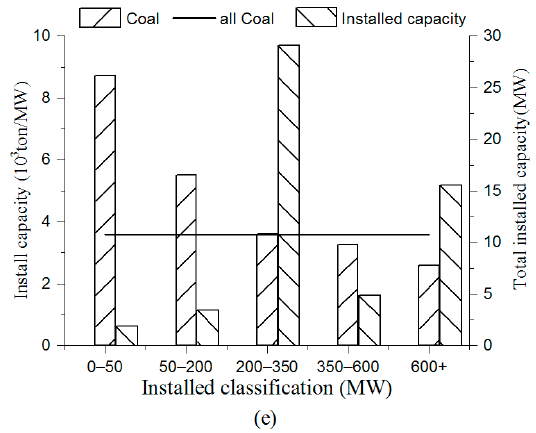
Figure 6. Installed capacity and installed efficiency: ( a ) installed capacity and SO 2 emissions installed efficiency, ( b ) installed capacity and NO x emissions installed efficiency, ( c ) installed capacity and PM emissions installed efficiency, ( d ) installed capacity and PM 2.5 emissions installed efficiency, ( e ) installed capacity and coal consumption installed efficiency.